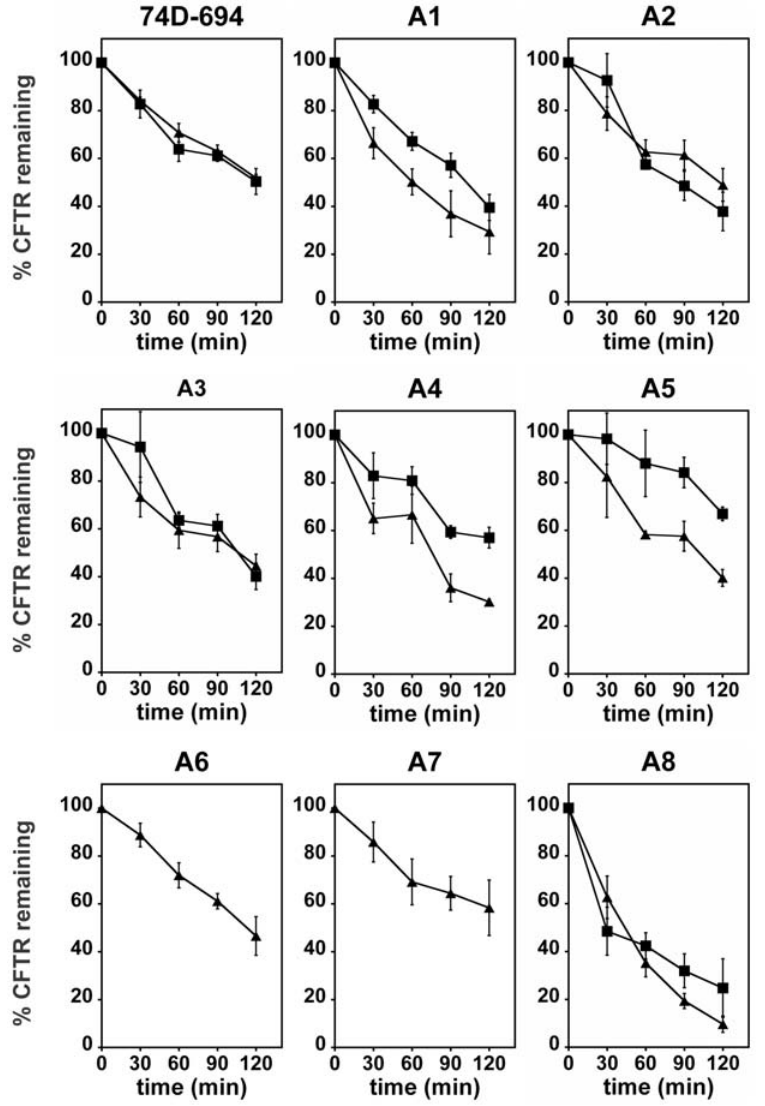
Figure 11. CFTR degradation monitored by cycloheximide-chase. The indicated strains, either [ psi 2 ] (triangles) or [ PSI + ] (squares), were grown to early log phase at 28 u C, then cycloheximide was added at a final concentration of 200 m g/mL. Aliquots were taken periodically and total protein extracts were prepared and subjected to SDS-PAGE and immunoblot analysis as described in Materials and Methods. Immunoblots were quantified by PhosphorImager analysis and the amount of CFTR at time zero was set to 100% (representative blots for each strain are shown on Supplemental Figure S2). Error bars represent the standard error of 3 to 6 independent experiments.